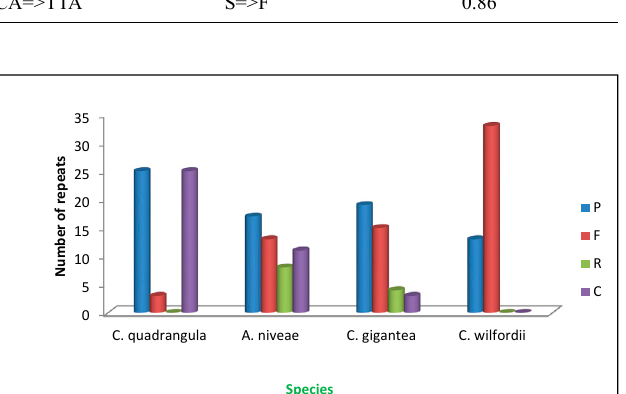
Fig. 4: SSR types in C. quadrangula, H. pottsii, A. nivea , and C. gigantea cp